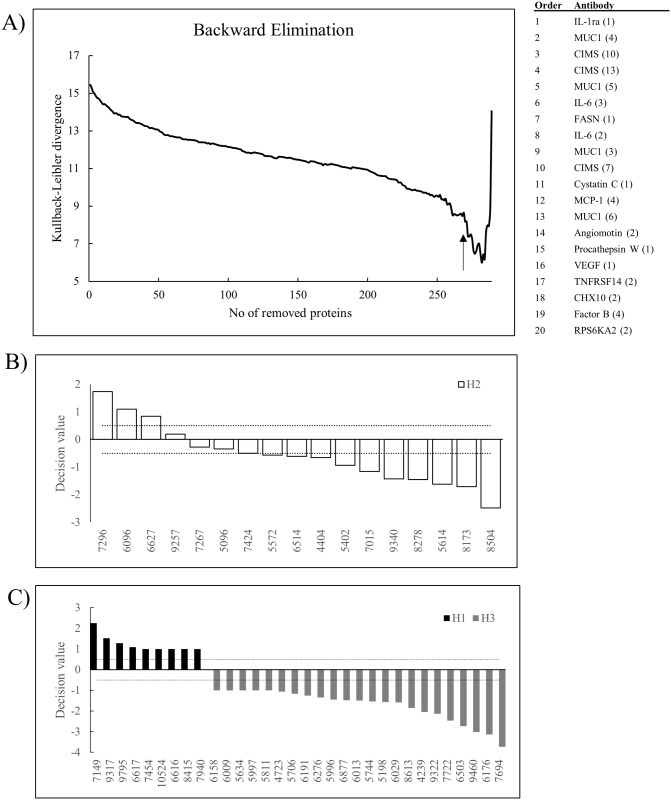
First model for refined molecular grading of breast cancer.A) Backward elimination analysis of the data set (grade 1 and grade 3 tumors), resulting in a condensed signature of 20 antibodies (indicated by an arrow). The panel of antibodies (specificities) are shown (in order of last removed antibody). B) A frozen SVM classification model was generated using the 20-plex antibody panel in A, based on all grade 1 and 3 tumors. The grade 2 tumors were then applied as test set. The resulting classification decision values are shown, where tumors with values ≥ 0.5 are defined as being more similar grade 1 tumors, 0.5 to -0.5 is defined as a grey zone (i.e. grade 2 tumors), and ≤ -0.5 are defined as being more similar to grade 3 tumors. C) The decision values for the grade 1 and grade 3 tumors used to build the SVM model are plotted. The same arbitrary cut-off as in B) is indicated (dashed line).